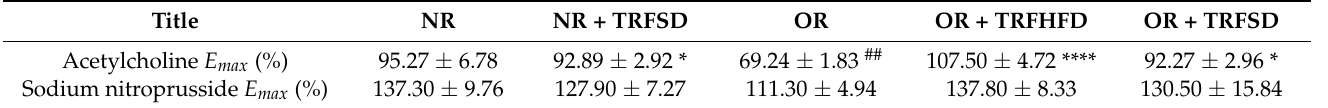
Figure 3. Endothelium-dependent and endothelium-independent relaxations in the thoracic aorta of rats: ( A ) Concentration-response curves to ACh (10 − 9 –10 − 4 M); ( B ) Concentration-response curves to sodium nitroprusside (10 − 9 –10 − 4 M). Data are presented as mean ± SEM ( n = 7). Relaxations were expressed as a percentage of the contraction induced by phenylephrine (10 − 6 M). ## p < 0.01 vs. NR. * p < 0.05 and **** p < 0.0001 vs. OR. Table 4. Relaxation to ACh and sodium nitroprusside in the thoracic